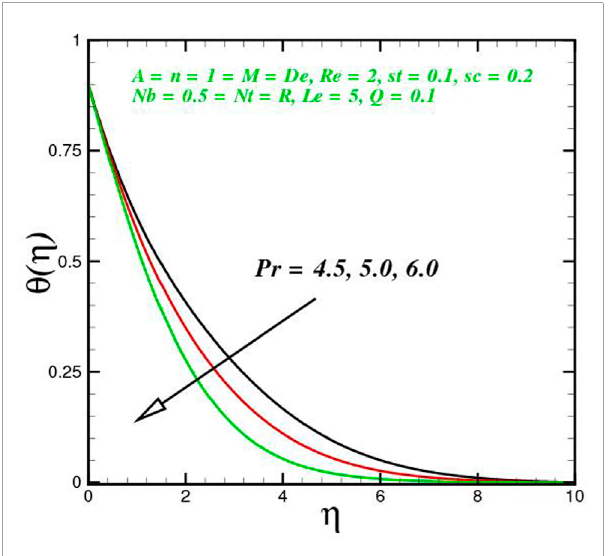
FIGURE 8 θ ( η ) , alteration via Nt.